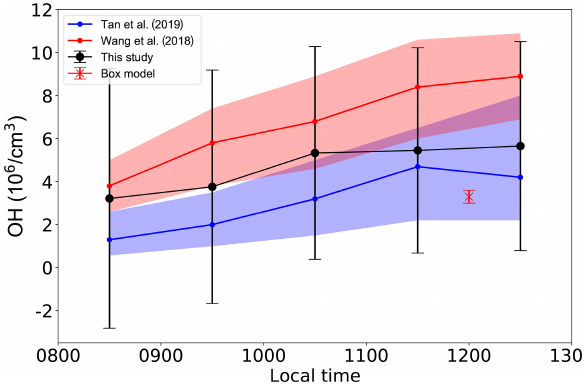
Figure 4. Hourly average OH concentrations between 08:00 and 13:00LT derived from the OBM are shown in the black line with black dots; observed OH concentrations by Tan et al. (2019) are shown in the blue line and blue shade; calculated OH concentra- tions by Y. Wang et al. (2018) are shown in the red line and red shade. The blue shade denotes the 25% and 75% percentiles of the data; the red shade indicates the 95% confidence interval of the data. The red cross with red vertical whiskers denotes the mean OH concentration and 1 standard deviation, respectively, calculated by a box model constrained by observed ambient conditions during the two